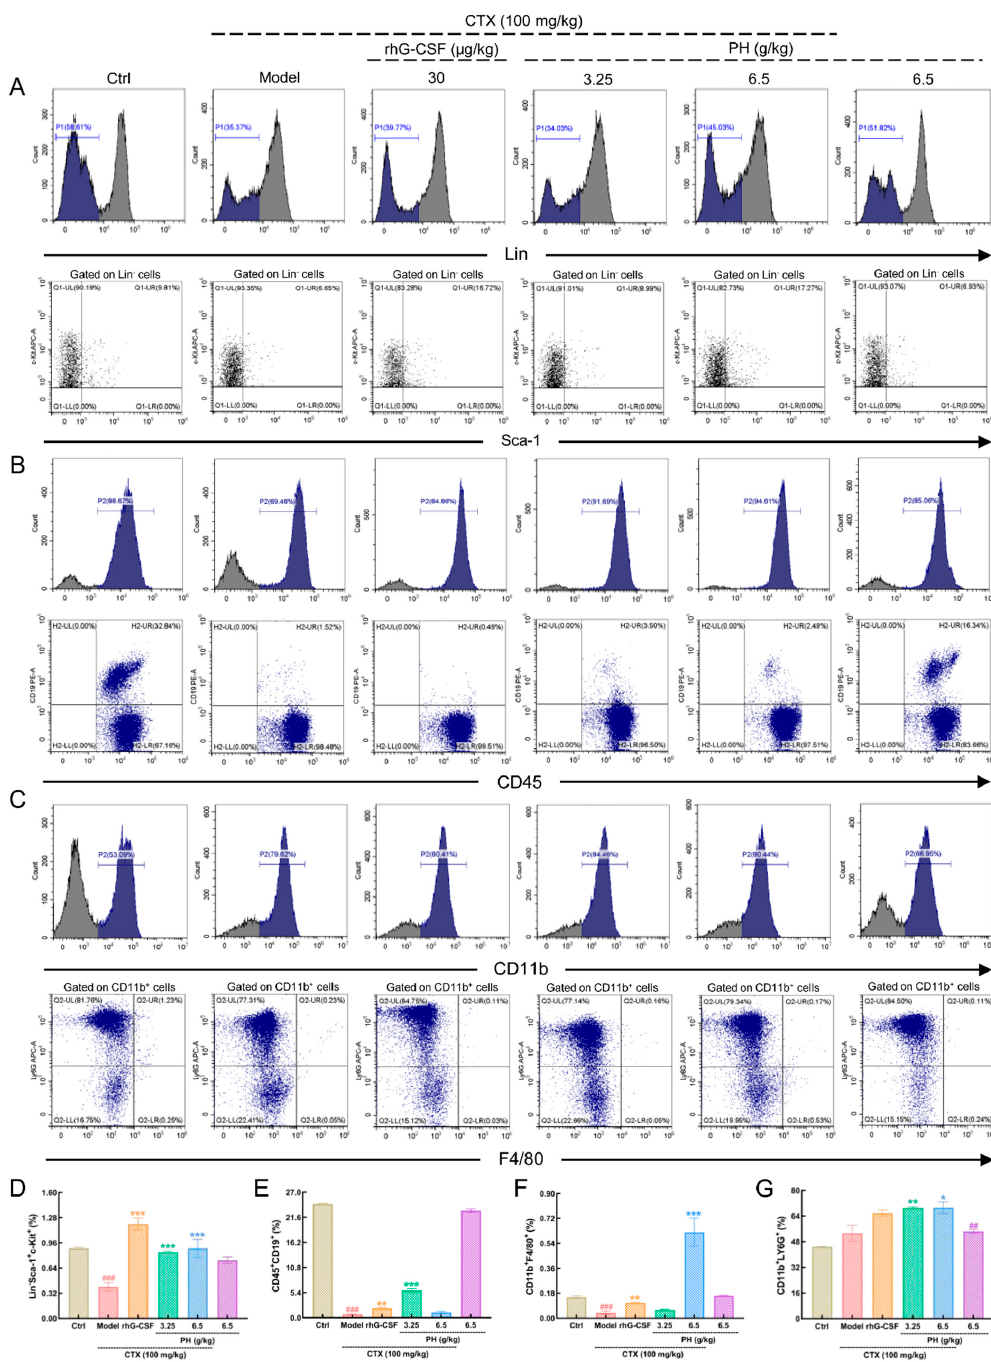
Figure 2. PH enhanced the levels of bone marrow mononuclear cells component. In bone marrow of the mice with hematopoietic dysfunction, PH enhanced ( A ) the levels of HSPC (represented by Lin − Sca-1 + c-Kit + ), ( B ) the levels of B lymphocytes (represented by CD45 + CD19 + ), ( C ) the levels of macrophages (represented by CD11b + F4/80 + ), and granulocytes (represented by CD11b + Ly6G + ), respectively. Quantitative analysis charts of ( D ) the levels of HSPCs, ( E ) the levels of B lymphocytes, ( F ) the levels of macrophages, and ( G ) granulocytes. Data are shown as the mean ± SD ( n = 5 mice/group in triplicate) and determined via a one-way ANOVA test followed by a Tukey’s post hoc test comparison. ## p < 0.01 and ### p < 0.001 vs. control group, * p < 0.05, ** p < 0.01 and *** p < 0.001 vs. model group. CTX, cyclophosphamide; Ctrl, control; Model, hematopoietic dysfunction model; rhG-CSF, recombinant human granulocyte colony-stimulating factor; PH, Protein hydrolysate